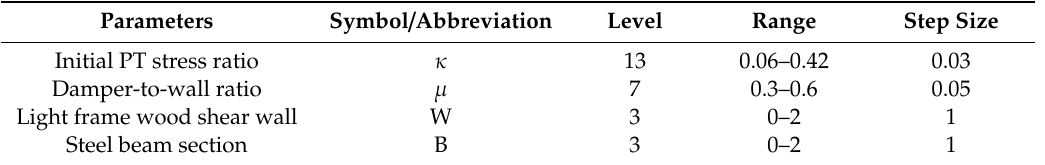
Table 4. Parameters selected for the analysis.